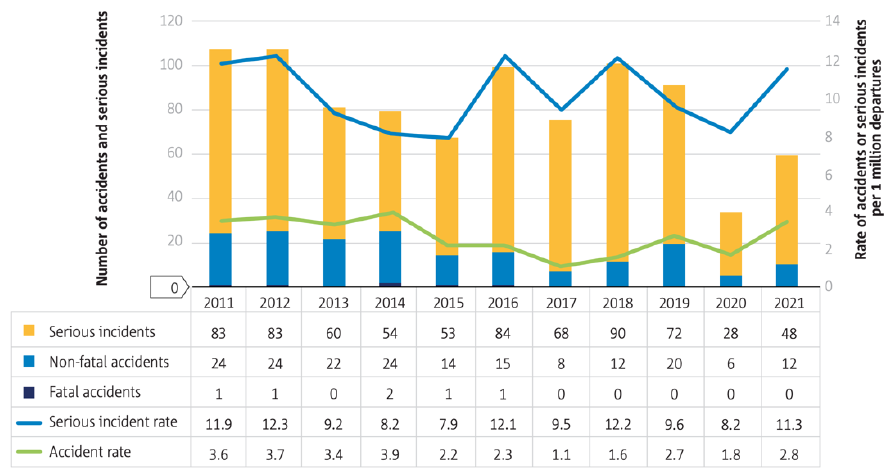
Figure 9. EASA 2022 Annual Safety Review [32], large airplane accidents.